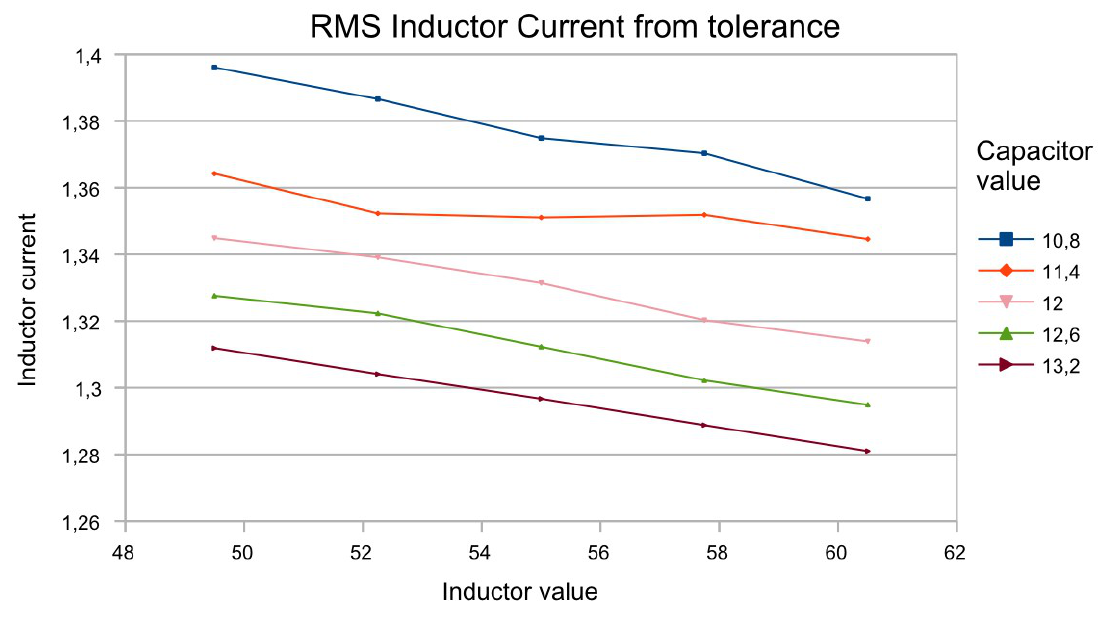
Figure 6. Tolerance analysis of the resonant current.